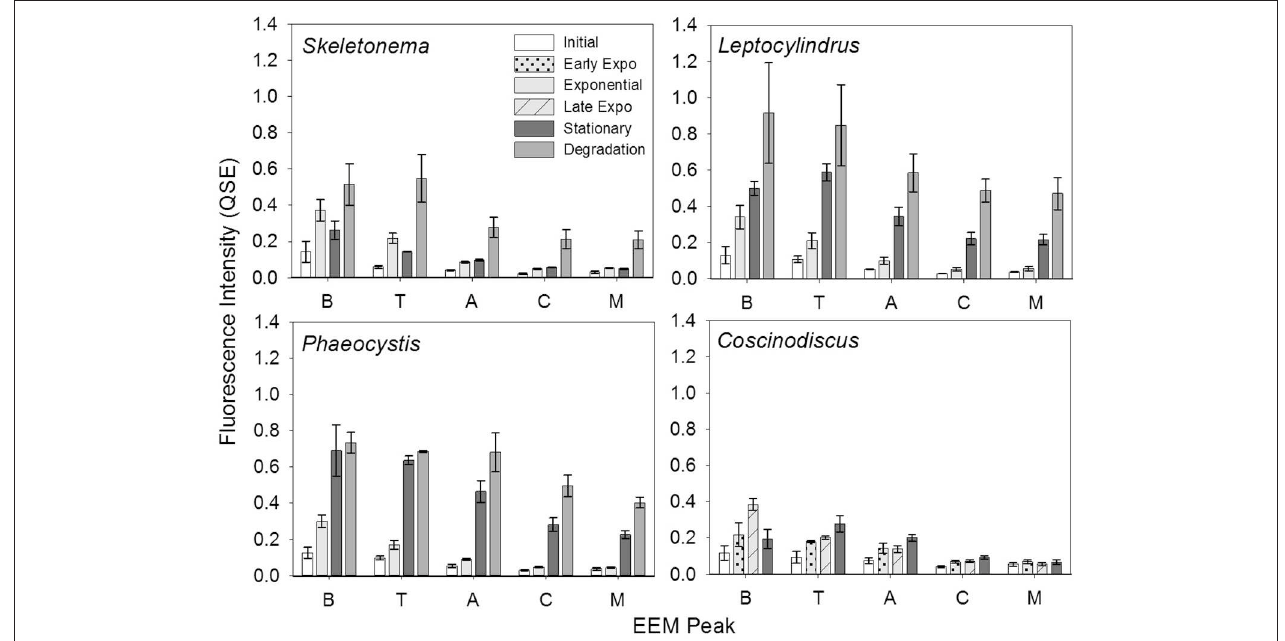
FIGURE 5 | CDOM fluorescence intensity of Coble EEM peaks over growth and degradation for genera Skeletonema ( n = 3), Leptocylindrus ( n = 2–4), Phaeocystis ( n = 3), and Coscinodiscus ( n = 3–4). Note the different growth stages for Coscinodiscus sp. All data are presented as mean ± standard error.